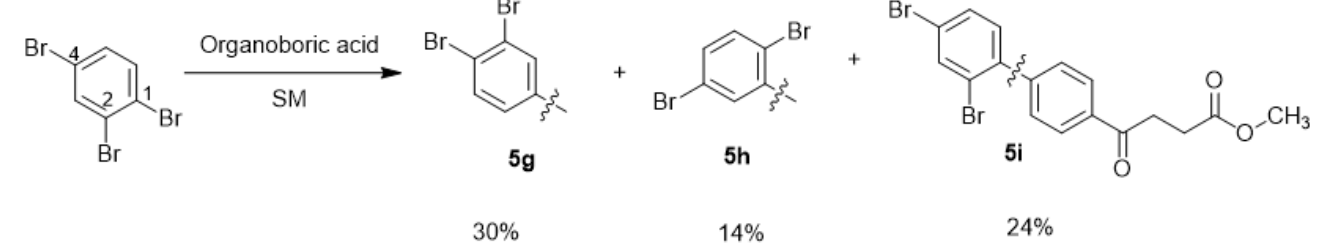
Figure 2. Sterically hindered C-2 position disfavors the SM coupling.